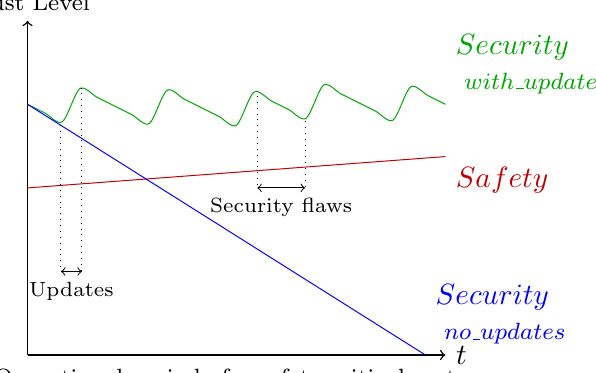
Figure 1. Safety and security trust levels